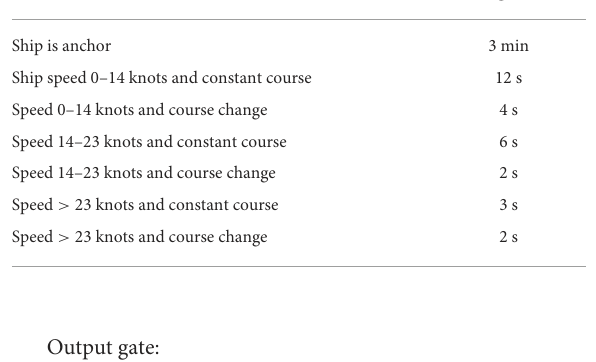
TABLE 1 Class A AIS message sending interval. Vessel travel status Sending